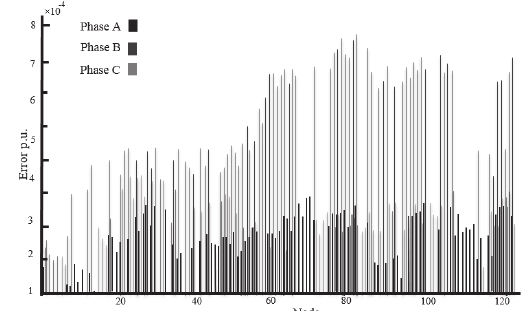
Fig. 3. Difference in voltage of Pn19k2-IEEE34 compared with benchmark case